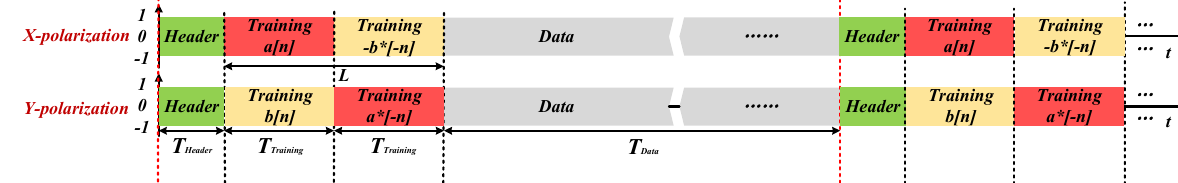
Figure 1. Frame structure diagram.